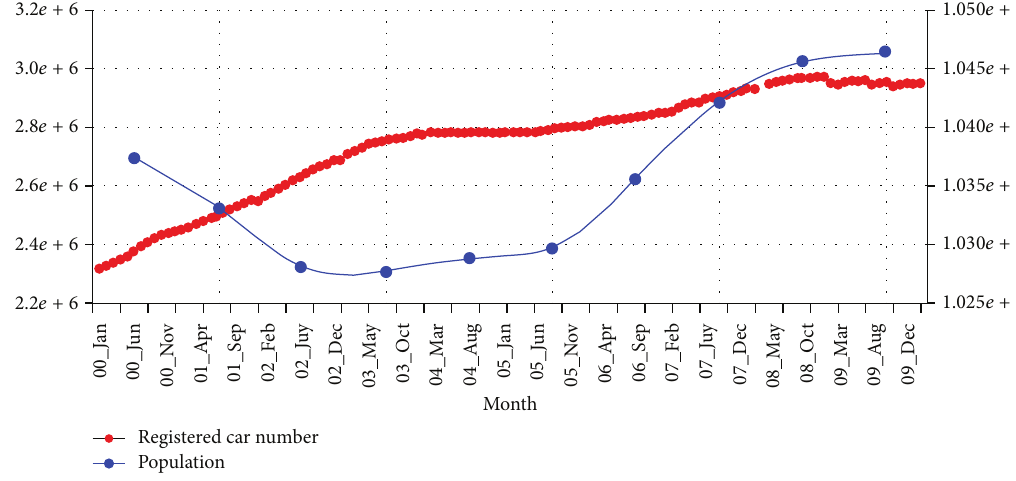
Figure 3: The number of registered car and population between 2000 and